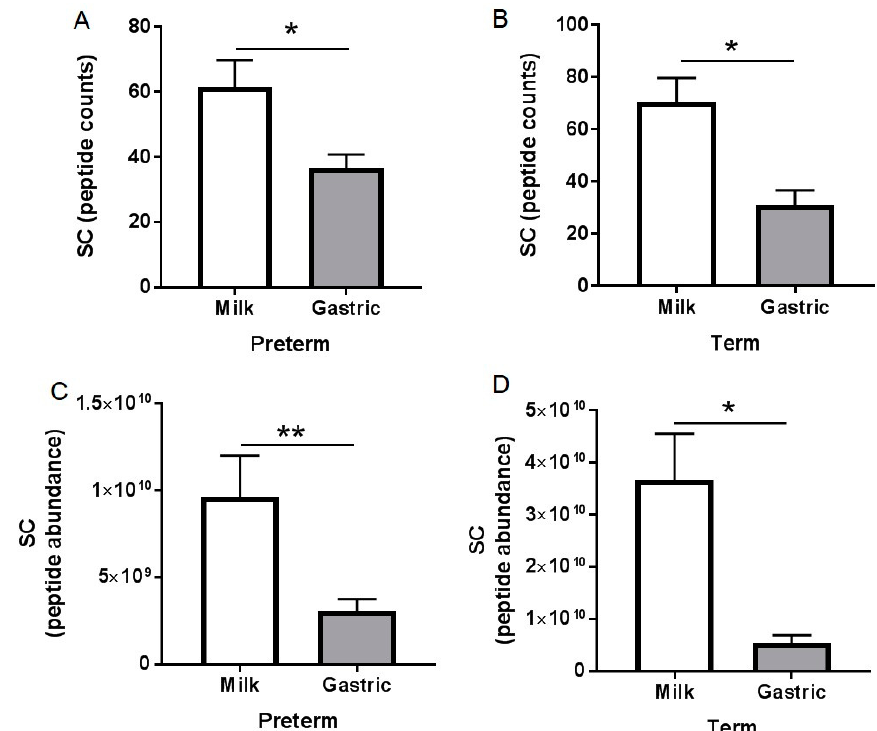
Figure 4. Peptides counts and abundance of SC (f19–603 of PIgR) in human milk and gastric samples from mother–infant pairs with preterm delivery (23–32 week of gestational age (GA), 7–98 days of postnatal age) and term delivery (38–40 week of GA, 16–42 days of postnatal age. Peptides counts of SC ( A ) in preterm infant samples; ( B ) in term infant samples. Peptide abundance of SC ( C ) in preterm infant samples and ( D ) in term infant samples. Values are mean ± SEM, n = 15 for preterm infants and n = 8 for term infants. Asterisks show statistical significant differences between variables (** p < 0.01; * p < 0.05) using the Wilcoxon matched-pairs signed-rank test.